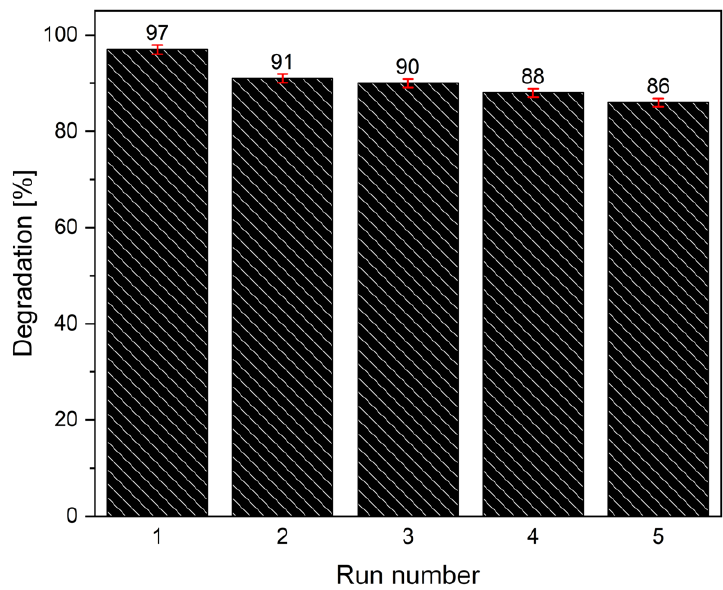
Figure 9. Reusability tests for TiO 2 -rGO solar sample in the 2,4 D photocatalytic degradation.